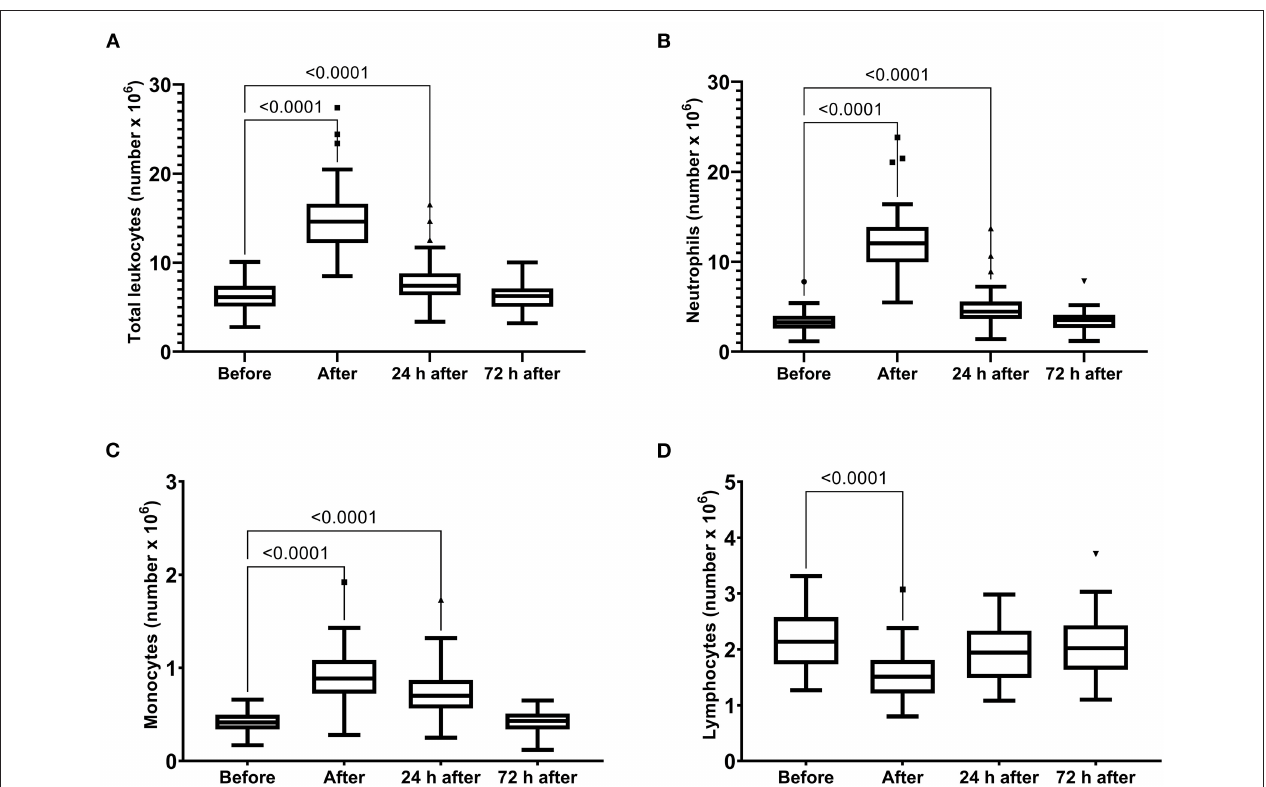
TABLE 1 | Correlation of changes in the number of leukocytes and changes in the muscle damage markers. 1 Number of leukocytes 1 Number of neutrophils 1 Number of monocytes p r p r p r 0.44